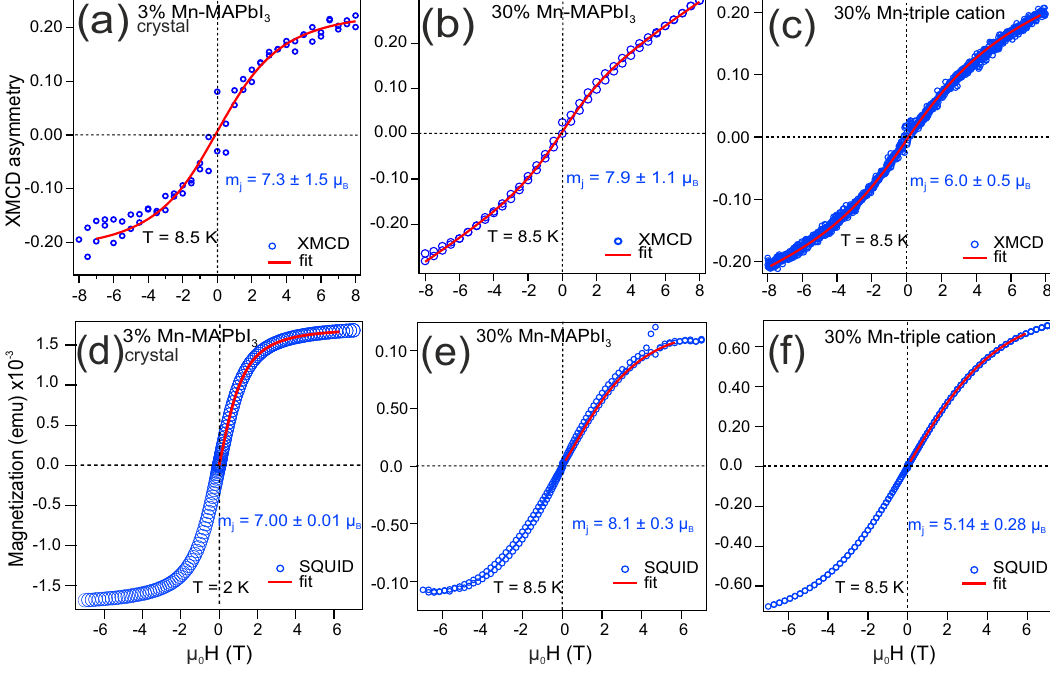
Fig. 4 Magnetic- fi eld ( H ) dependence of the X-ray magnetic circular dichroism (XMCD) asymmetry at the Mn L 3 -edge and magnetization M ( H ) using superconducting quantum interference device (SQUID). a – c H dependence with the fi eld applied perpendicular to the surface at 8.5 K for a MAMn 0.03 Pb 0.97 I 3 crystal, b Mn-doped MAPbI 3 , and c triple-cation fi lms. M ( H ) was measured with SQUID for d MAMn 0.03 Pb 0.97 I 3 crystal at 2 K, and e , f for Mn-doped MAPbI 3 and triple-cation fi lms at 8.5 K, respectively. The magnetic fi eld applied in SQUID is parallel to the sample plane. Red solid lines represent the fi ts of the Brillouin function to the